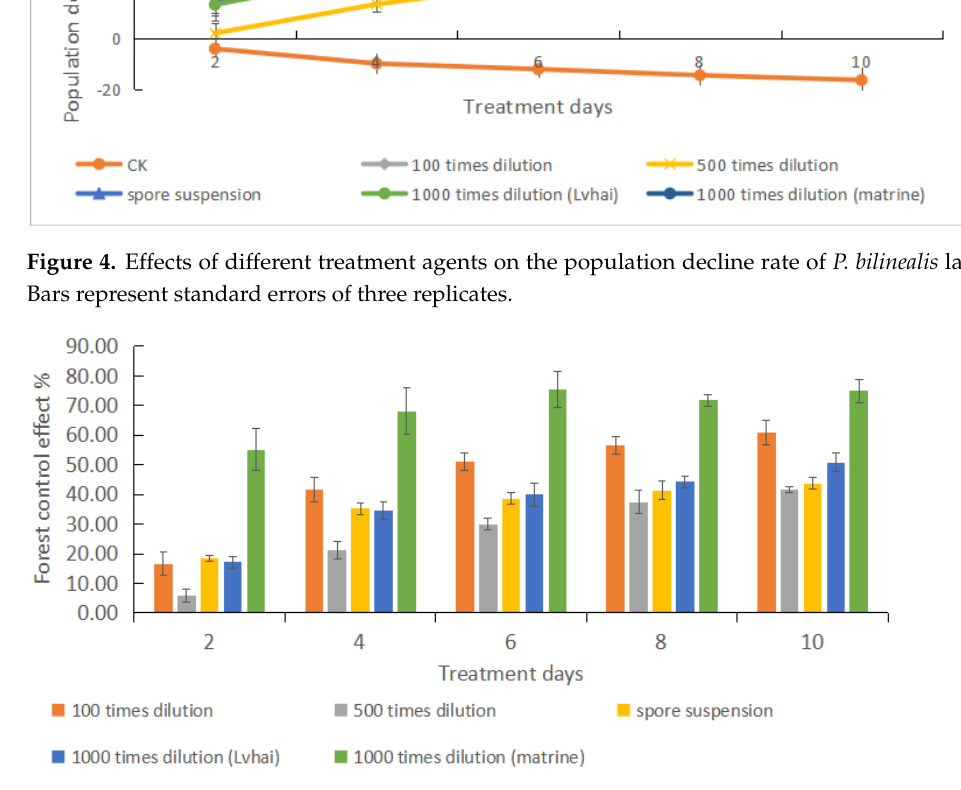
Figure 5. Forest control effect of spraying different treatment agents on P. bilinealis larvae. Bars represent standard errors of three replicates.